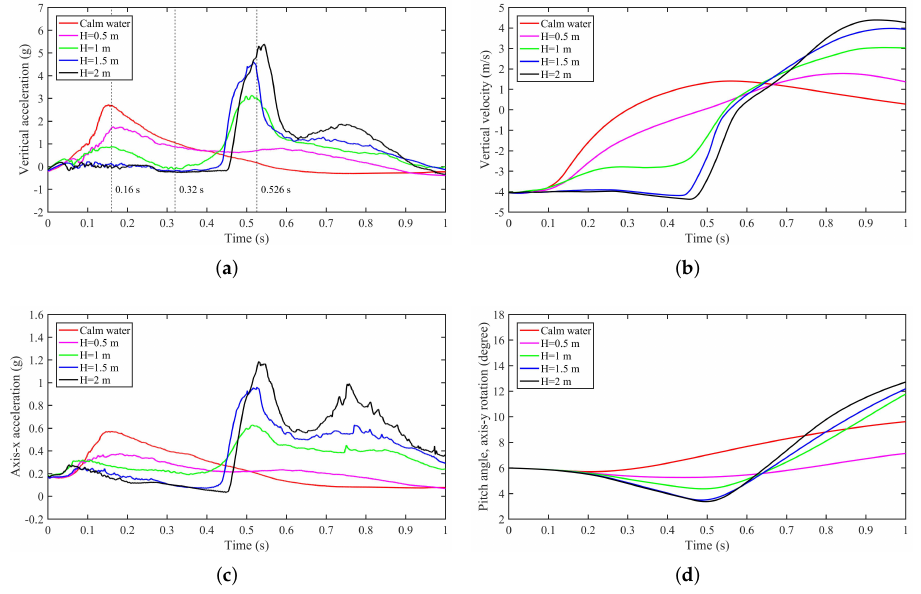
Figure 14. Comparison of time–history results of aircraft wave-landing with different wave lengths: